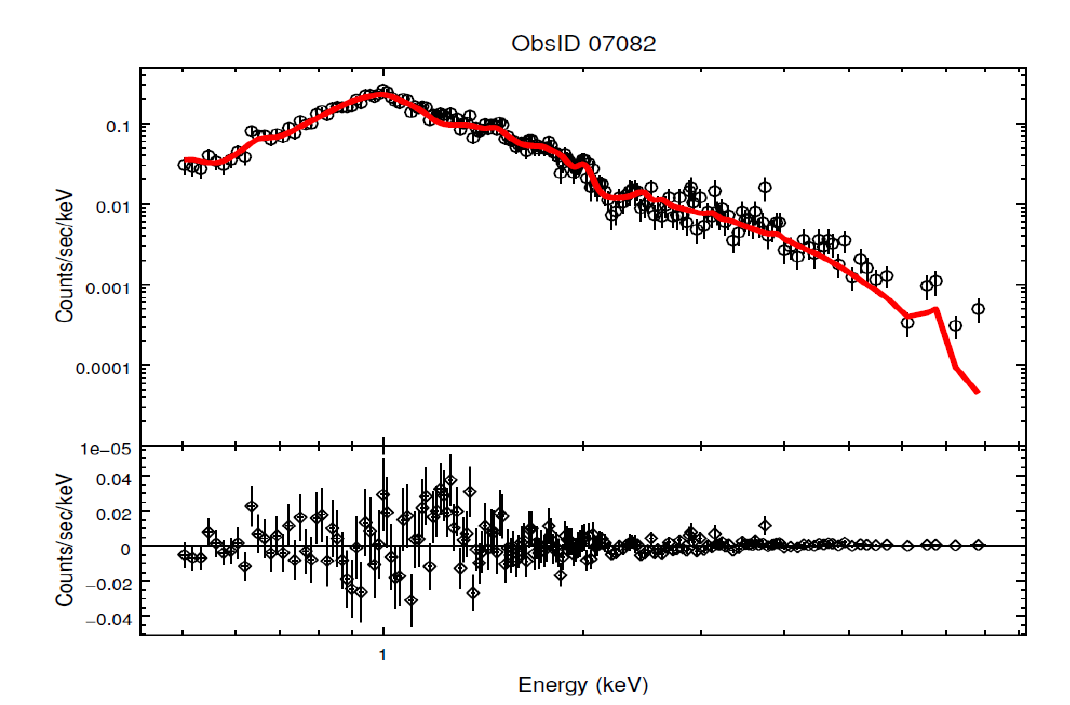
Figure 4. TV Cas Spectrum from Chandra Observation ID